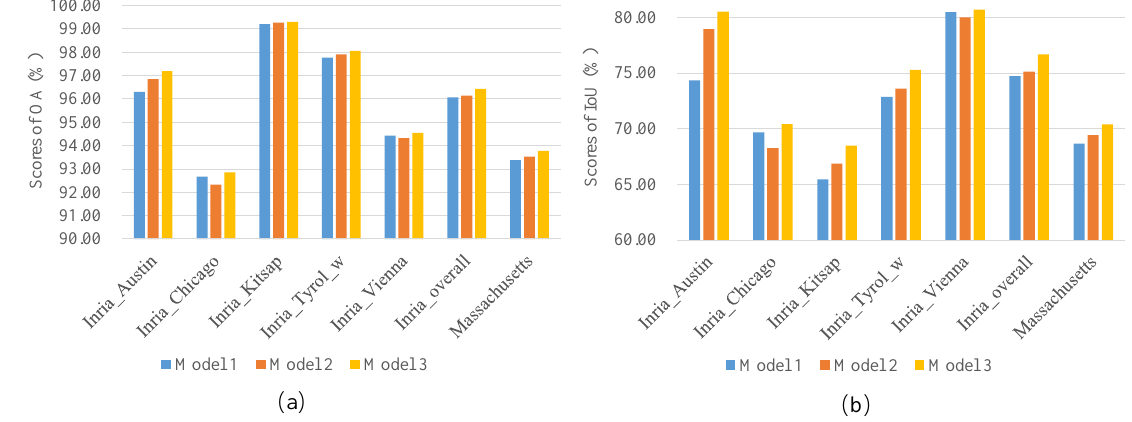
Figure 10. Robust study of non-local block. ( a ) Results in OA, ( b ) Results in